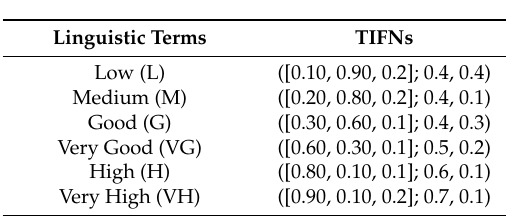
Table 1. Linguistic and TIFNs